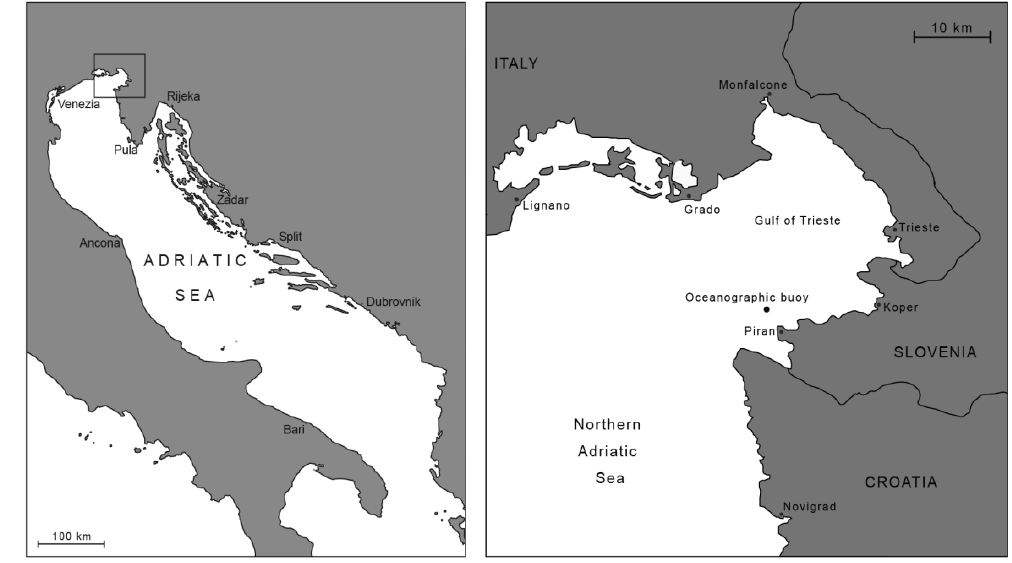
Figure 1: Study site; 1) the Northern Adriatic Sea (left), 2) Piran in the Gulf of Trieste (right) (map 839 Fig. 1. Study site; the northern Adriatic Sea (left), oceanographic buoy off Piran in the Gulf of Trieste (right). after Haselmair, 2008 840 (Geoffroy Saint-Hilaire, 1817) and pandora Pagellus erythri- nus (Linnaeus,